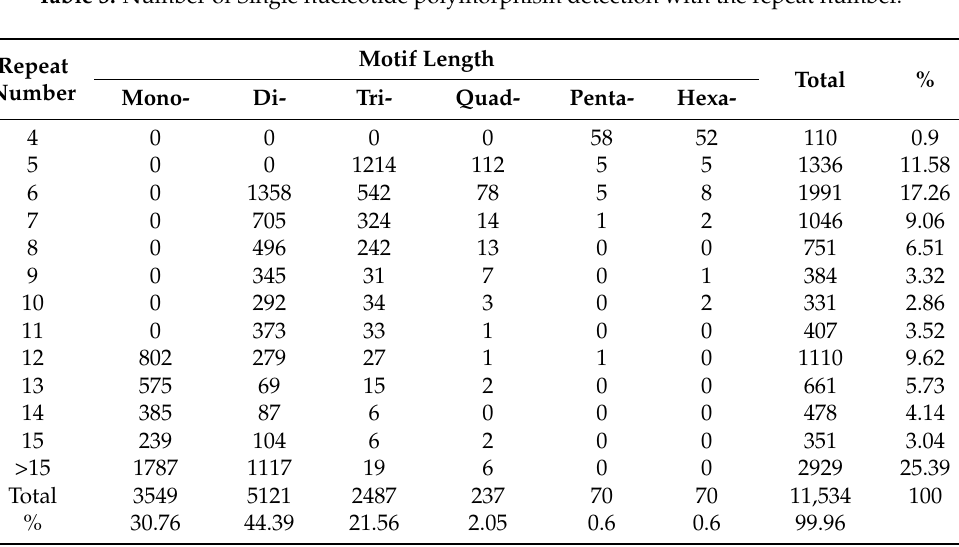
Table 3. Number of Single nucleotide polymorphism detection with the repeat